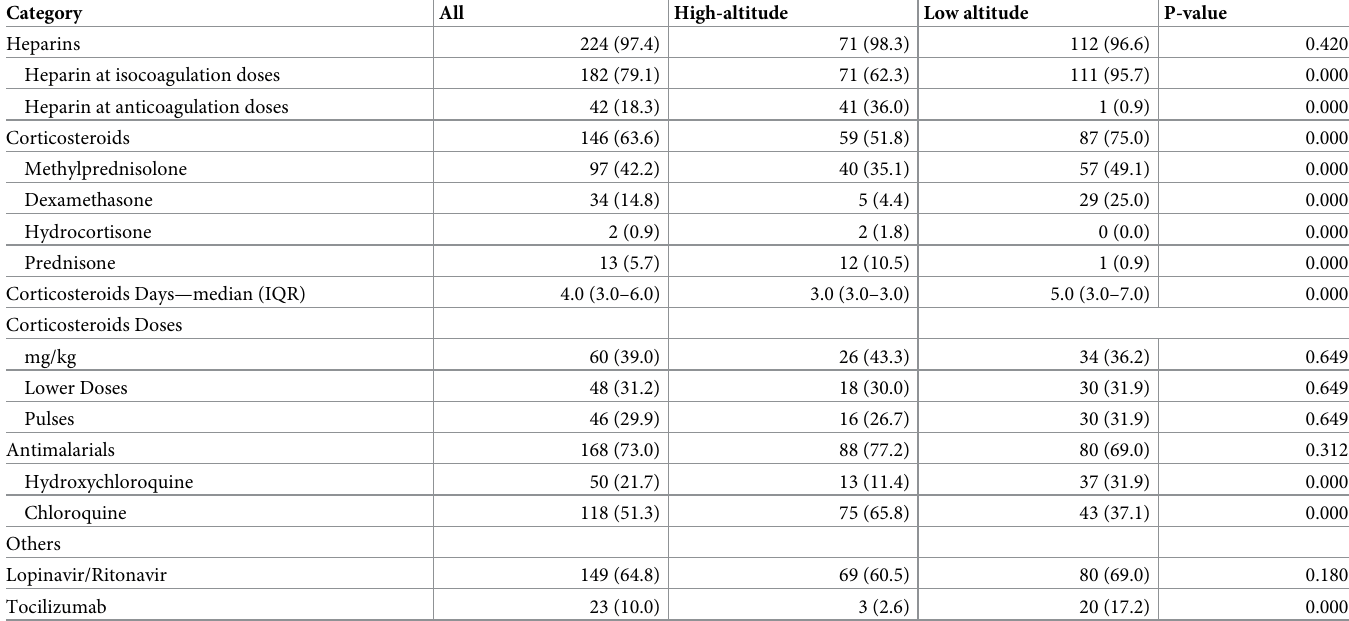
Table 5. Pharmaceutical treatment in the low and high-altitude